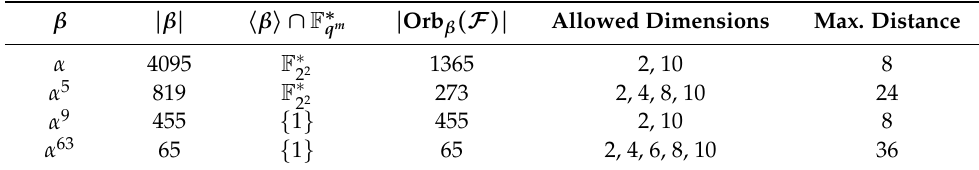
Table 1. Admissible dimensions for q = 2, n = 12, m =